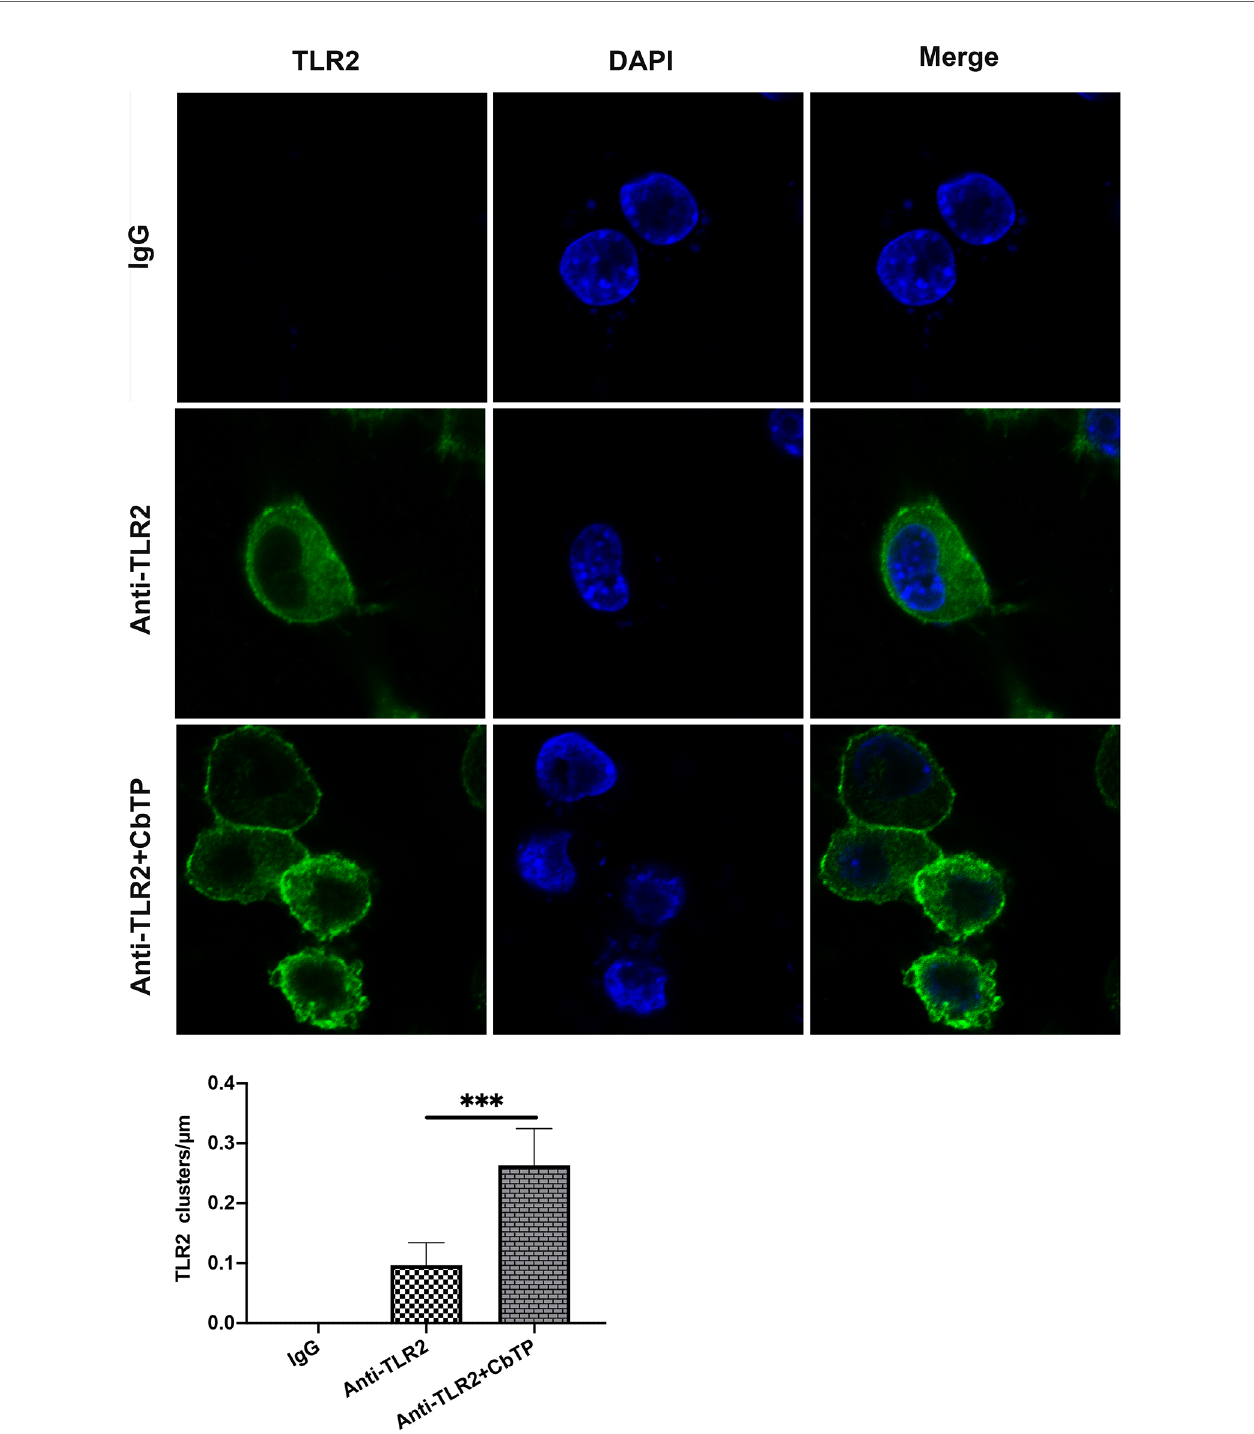
FIGURE 10 | CbTP enhances cell surface TLR2 cluster formation. RAW264.7 cells were treated with or without 10 m g/mL CbTP for 1 h at 37°C. Cells were then incubated with anti-mouse monoclonal antibody TLR2 (1 m g/mL) or isotype control IgG, washed, and stained with a FITC-conjugated anti-mouse IgG antibody. After washing and adherence to cover glass-bottom confocal dishes, the cells were fi xed with paraformaldehyde for 15 min at room temperature and mounted. The cell nuclei were stained with DAPI. Cells were imaged with the Leica TCS SP5 confocal system. Images were processed and fl uorescence was quanti fi ed with LAS AF software. In addition, to generate a fl uorescence histogram pro fi le, a line was drawn along the cell surface. Fluorescence intensities higher than 40 arbitrary units (isotype control staining) were considered clusters of TLR2 molecules. Statistical comparisons were performed by Student ’ s t test. The mean values ± standard deviation of 5 independent experiments were used to express the data. ***p ≤